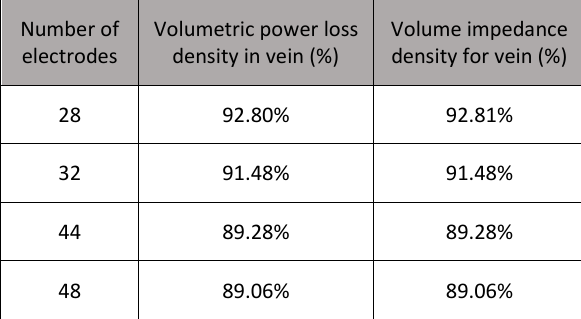
Table 2: Simulation results including the percentage of the volumetric power loss density and volume integration of volume impedance density for vein and with the electrode dimensions of r t = 1 mm and r g = 1 mm where all the surface electrodes were excited simultaneously as